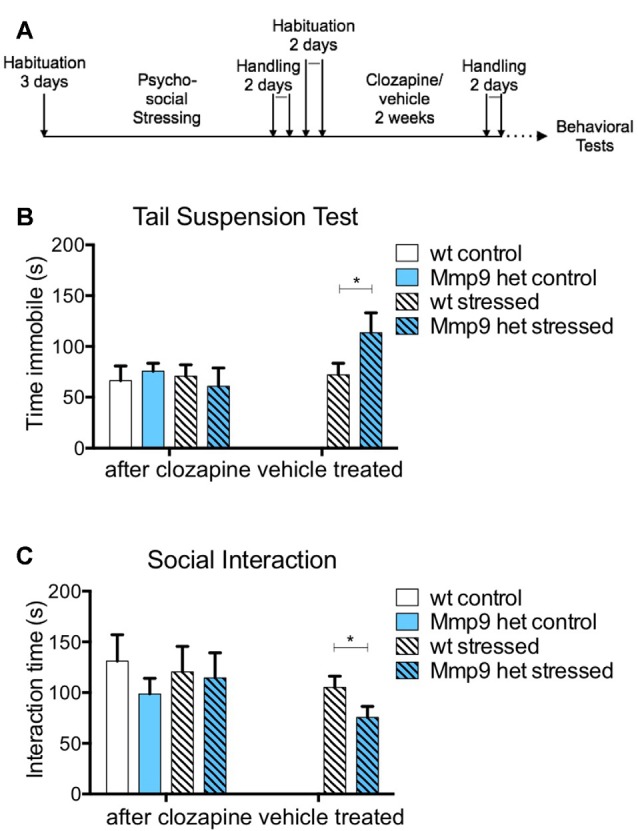
Effect of clozapine on negative symptoms. (A) Schematic diagram of clozapine treatment. (B) Clozapine treatment attenuated the increase in immobility in stressed Mmp-9 heterozygous mice in the tail suspension test compared with their non-stressed counterparts and stressed wt mice. No effects of clozapine were observed in the vehicle-treated group (individual t-test, p < 0.05). (C) Clozapine ameliorated the differences in interaction time between stressed and non-stressed wt and heterozygous mice. Vehicle treatment alone did not exert any effects in stressed heterozygous mice, which exhibited a significant decrease in interaction time (individual t-test, p < 0.05) compared with wt mice. wt, wt control mice; Het, Mmp-9 heterozygous mice. *p < 0.05.